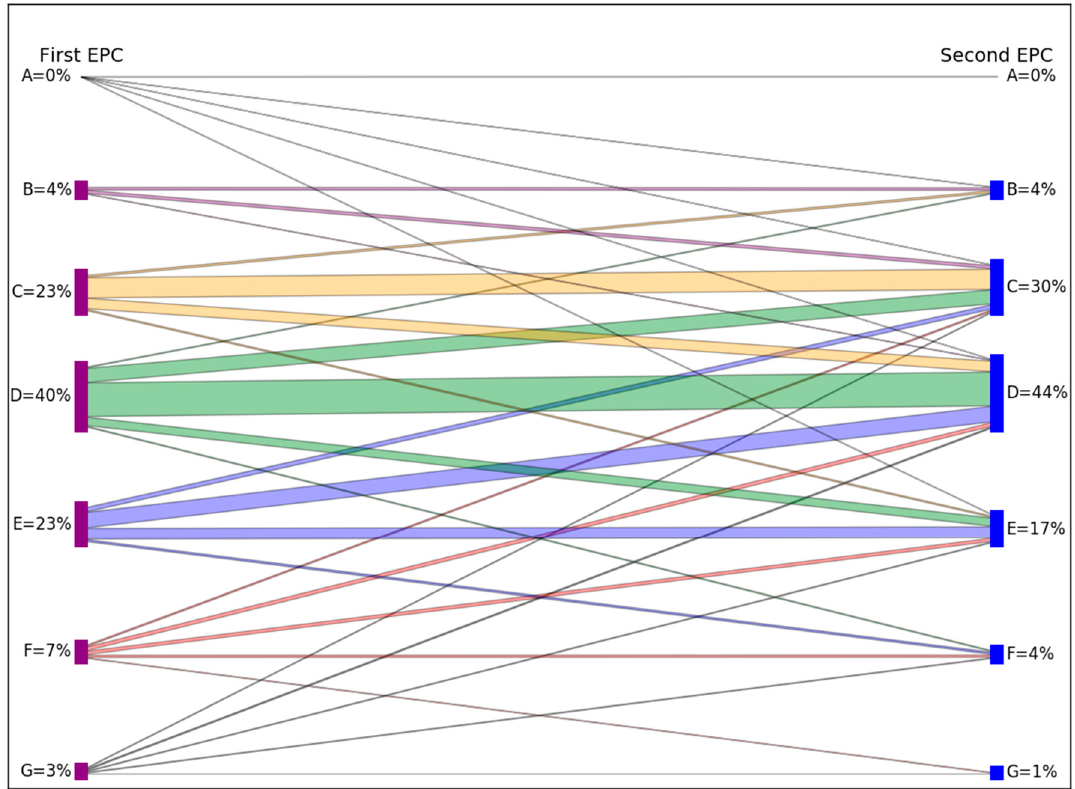
Figure 3. Visualisation of change in EPC band from first to second assessment, at a dwelling level. Line thickness represents number of dwellings making each particular transition. Transitions with less than 1% of dwellings are excluded for clarity.